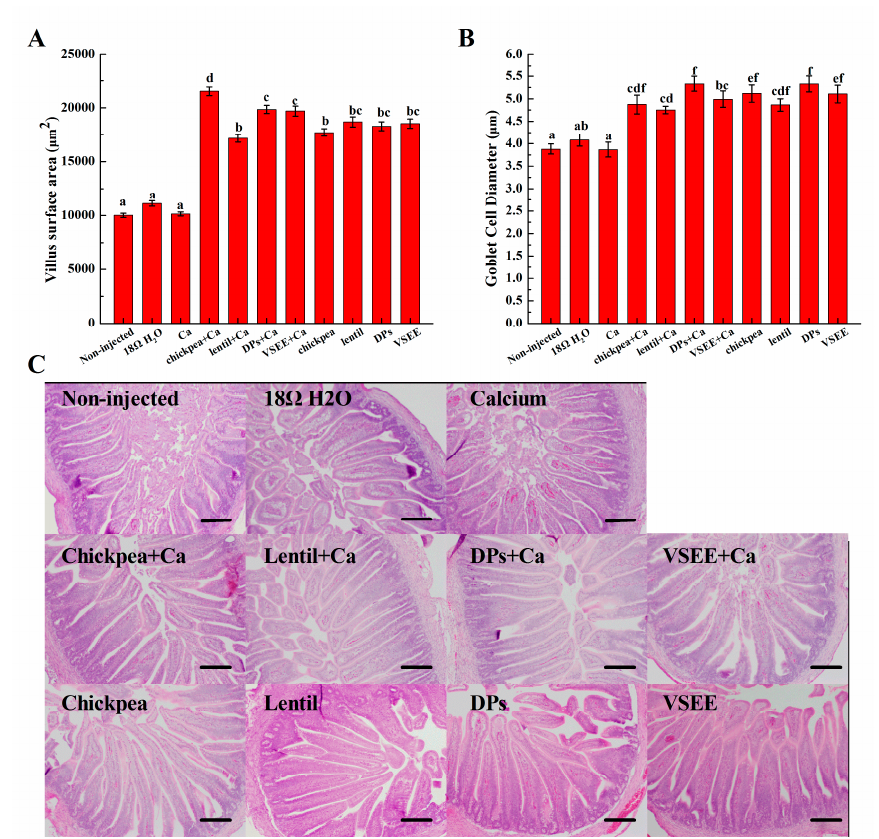
Figure 4. Effect of intra-amniotic administration of experimental solutions on: ( A ) the duodenal small intestinal villus surface area; and ( B ) goblet cells diameters. A representation of intestinal morphology from five dependent experiments in each group is shown ( C ). Values are means ± SEM, n = 5. Standard errors are represented by vertical bars. a–f Treatments groups not indicated by the same letter are significantly different ( p < 0.05). Bar = 100 μ m.